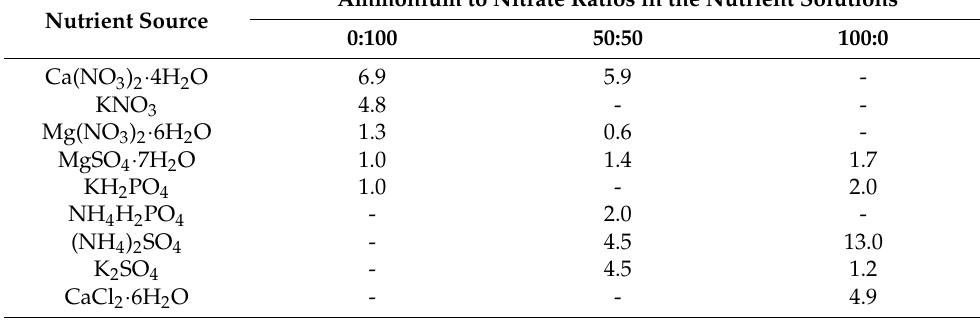
Table 1. Macronutrient composition (me · L − 1 ) along with a constant concentration (13.0 me · L − 1 ) of N, but three different ammonium to nitrate ratios, used as the treatment